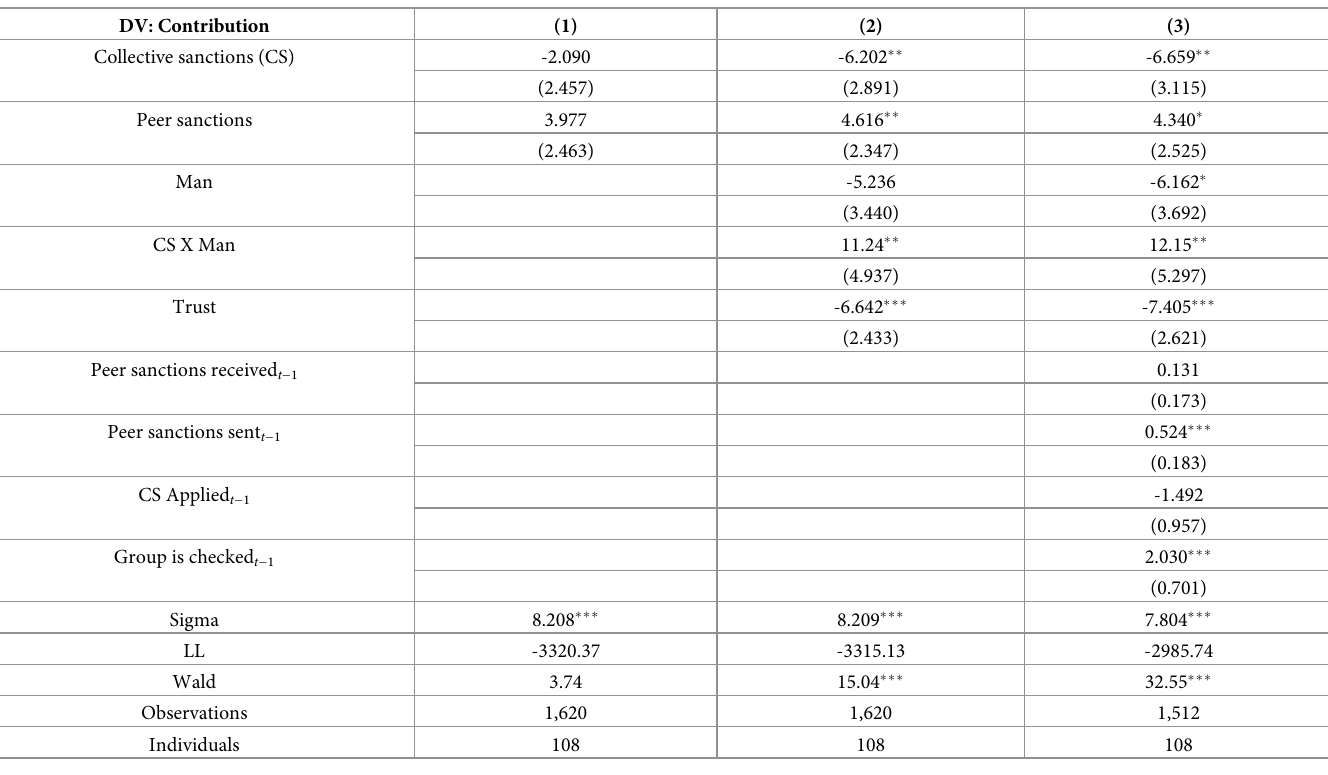
Table 5. DV: Contribution to the group project. Tobit random-effect baseline and two extended